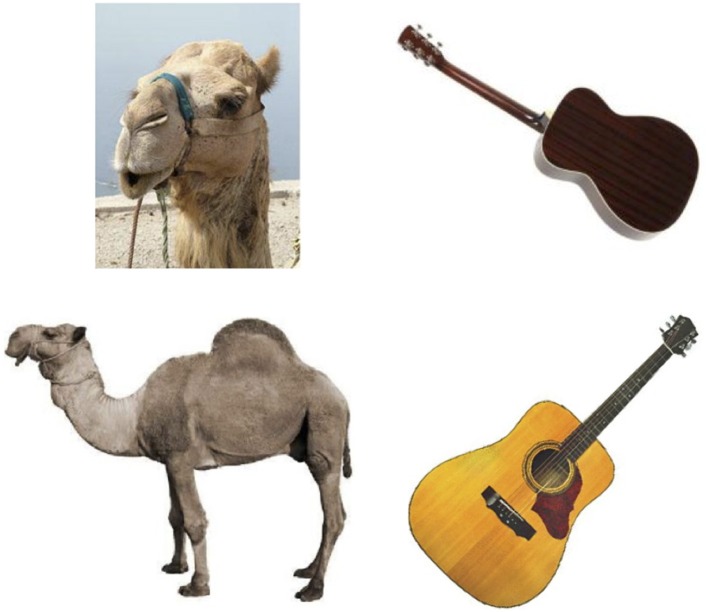
Examples of target picture stimuli CAMEL (left) and GUITAR (right) for Experiment 2 (top row) and Experiment 3 (bottom row). In the target pictures for Experiment 2, distractor parts (hump and knee for CAMEL, hole and fret for GUITAR) are not visible following Costa et al. (2005).